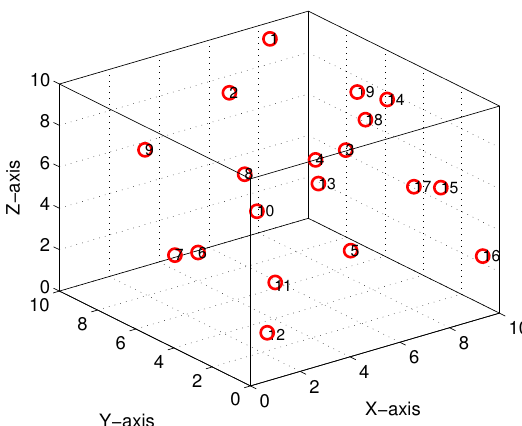
Figure 8. Simulation topology snapshot ( n = 19).